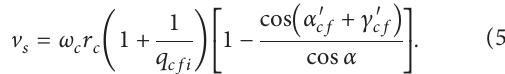
Figure 5: Meshing impact speed